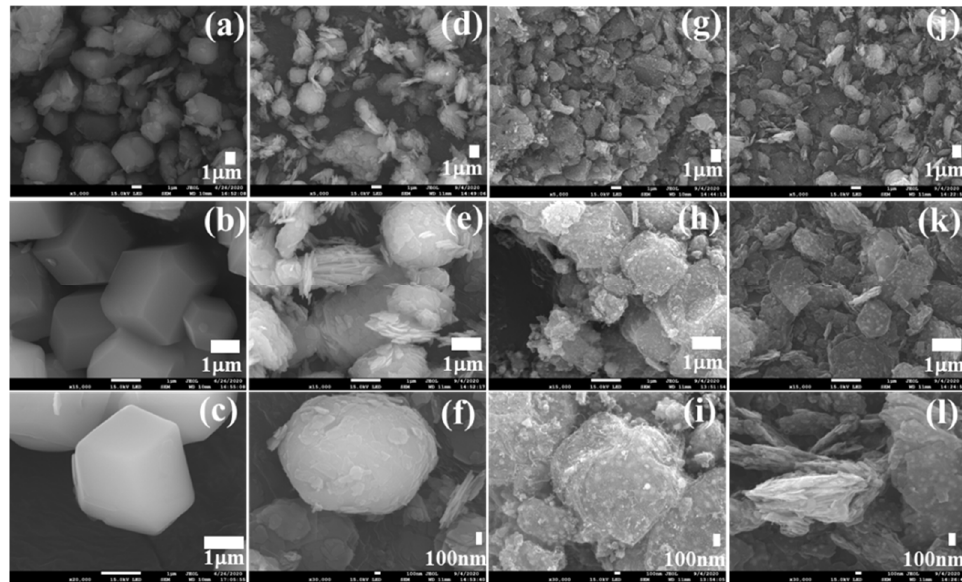
Figure 3. SEM images of ( a – c ) HZ, ( d – f ) 3% CNF-HZ, ( g – i ) HZNPC, ( j – l ) 3% CNF-HZNPC.